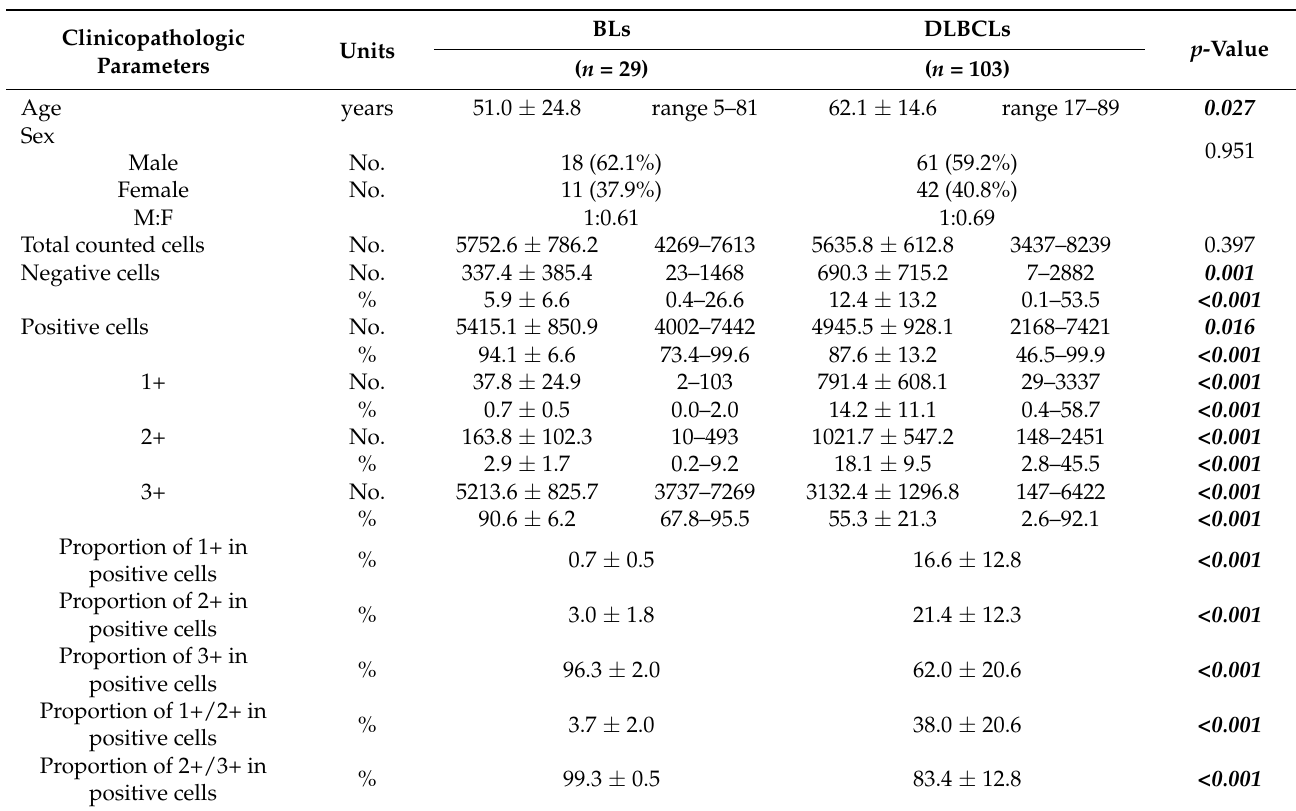
Table 1. Comparison of Ki-67 labeling index patterns between Burkitt lymphomas (BLs) and diffuse large B-cell lymphomas